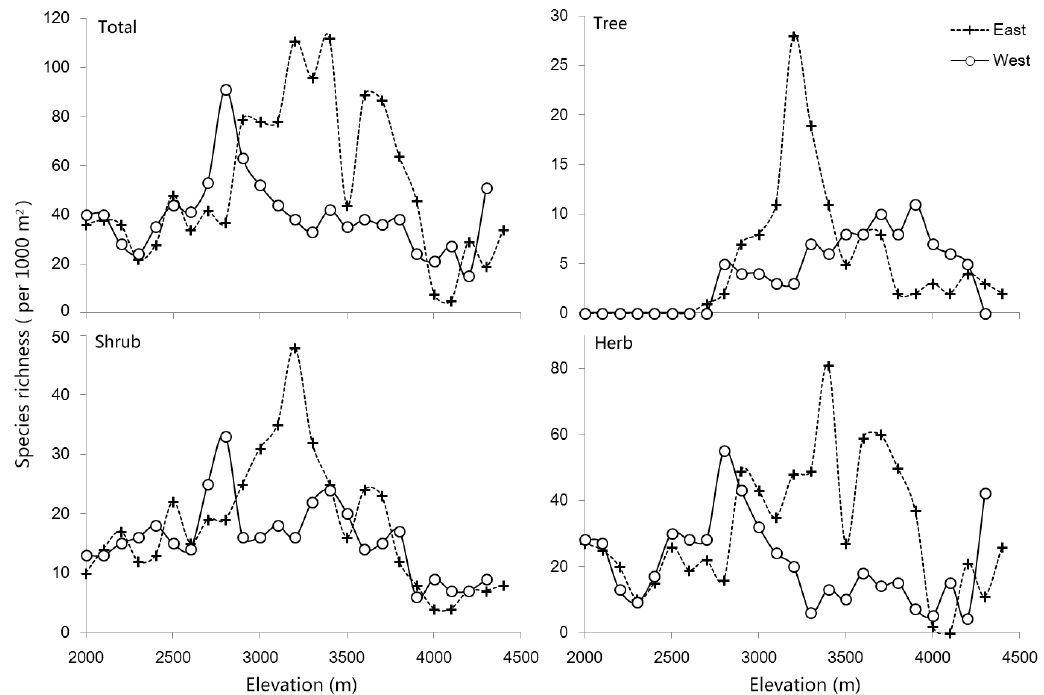
Figure 3. Elevation-related patterns of species richness of all plants and of trees, shrubs and herbs in the transects on western and eastern aspects of Baima Snow